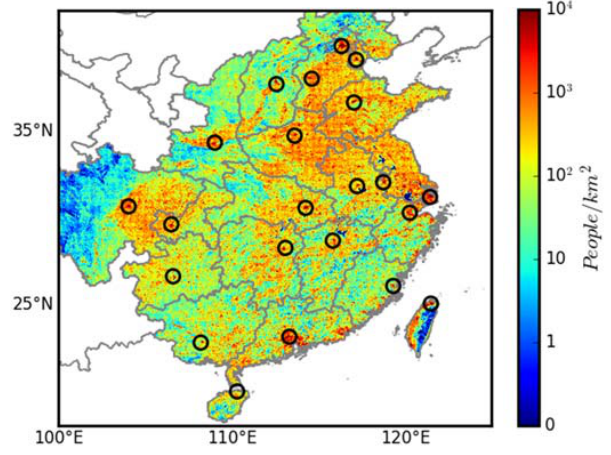
Figure 2. Spatial distribution of population density at a resolution of 0.01° × 0.01° in the study region in 2008. The locations of the capital cities of the provinces are marked by circles.